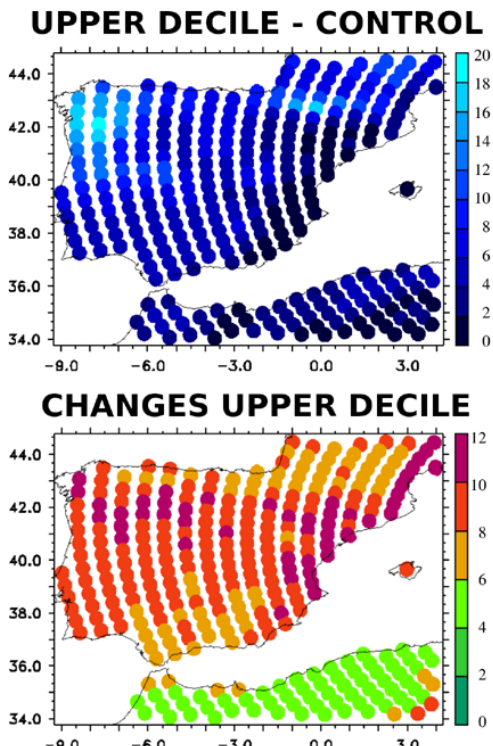
Fig. 7. In the top row the upper decile values of the precipitation (in mmday − 1 ), in the historical period simulations. In the bottom row, the percentages of exceedance of the historical upper decile values in the precipitations of the scenario